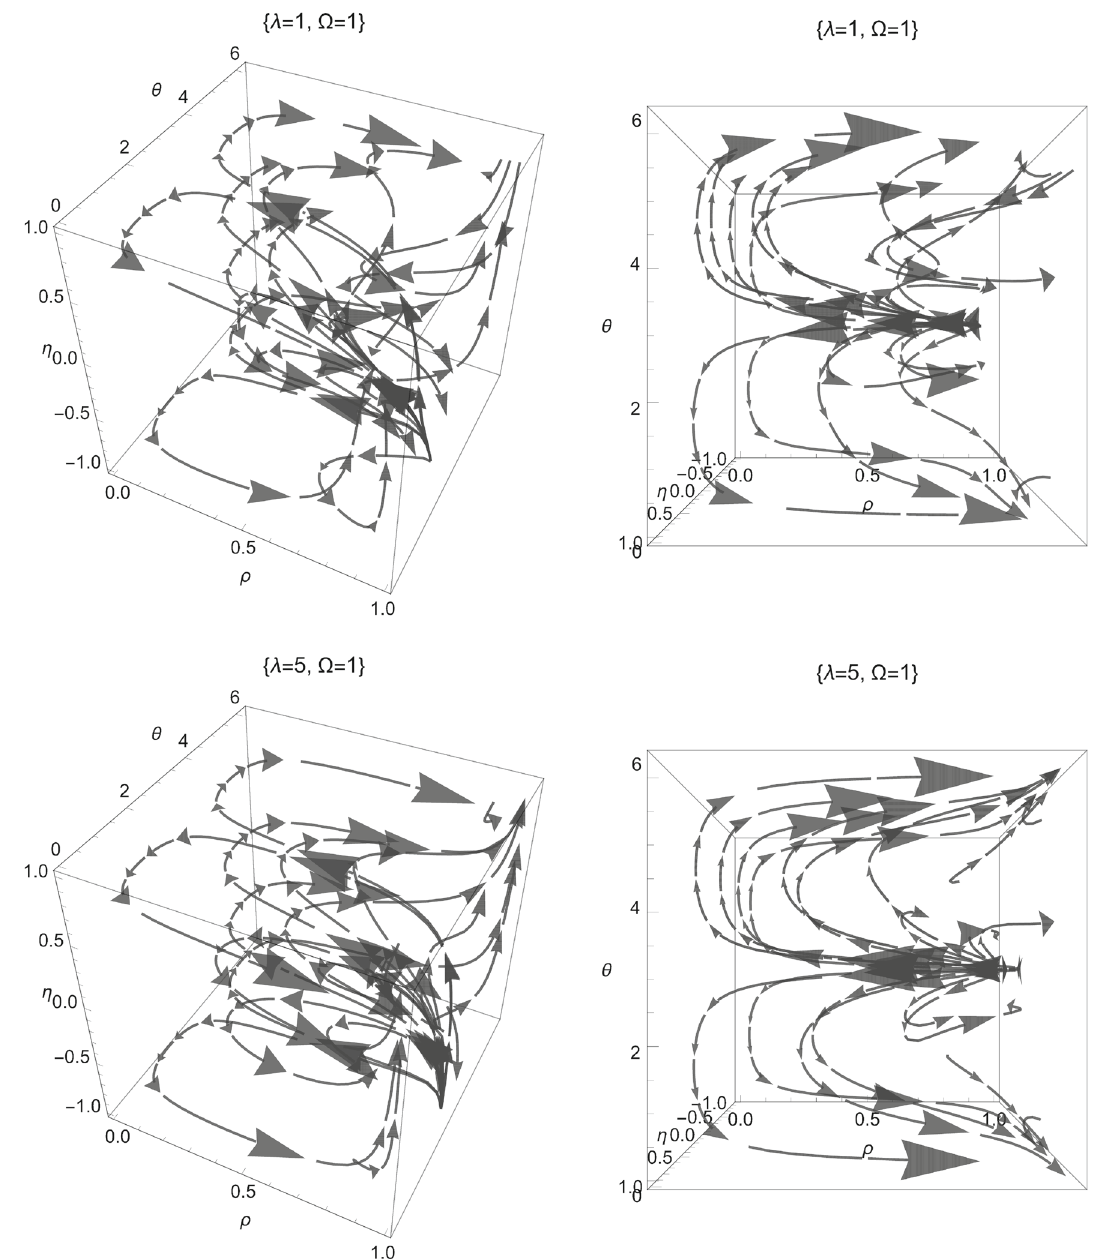
Fig. 4 Phase-space portraits for the three-dimensional dynamical sys- tem in the space (ρ,θ,η) for the Kantowski–Sachs spacetime and for ω = − 1 , that is (cid:18) = 1. First row are plots for λ = 1 while in the second row are plots with λ = 5 . The plots of the left and right columns